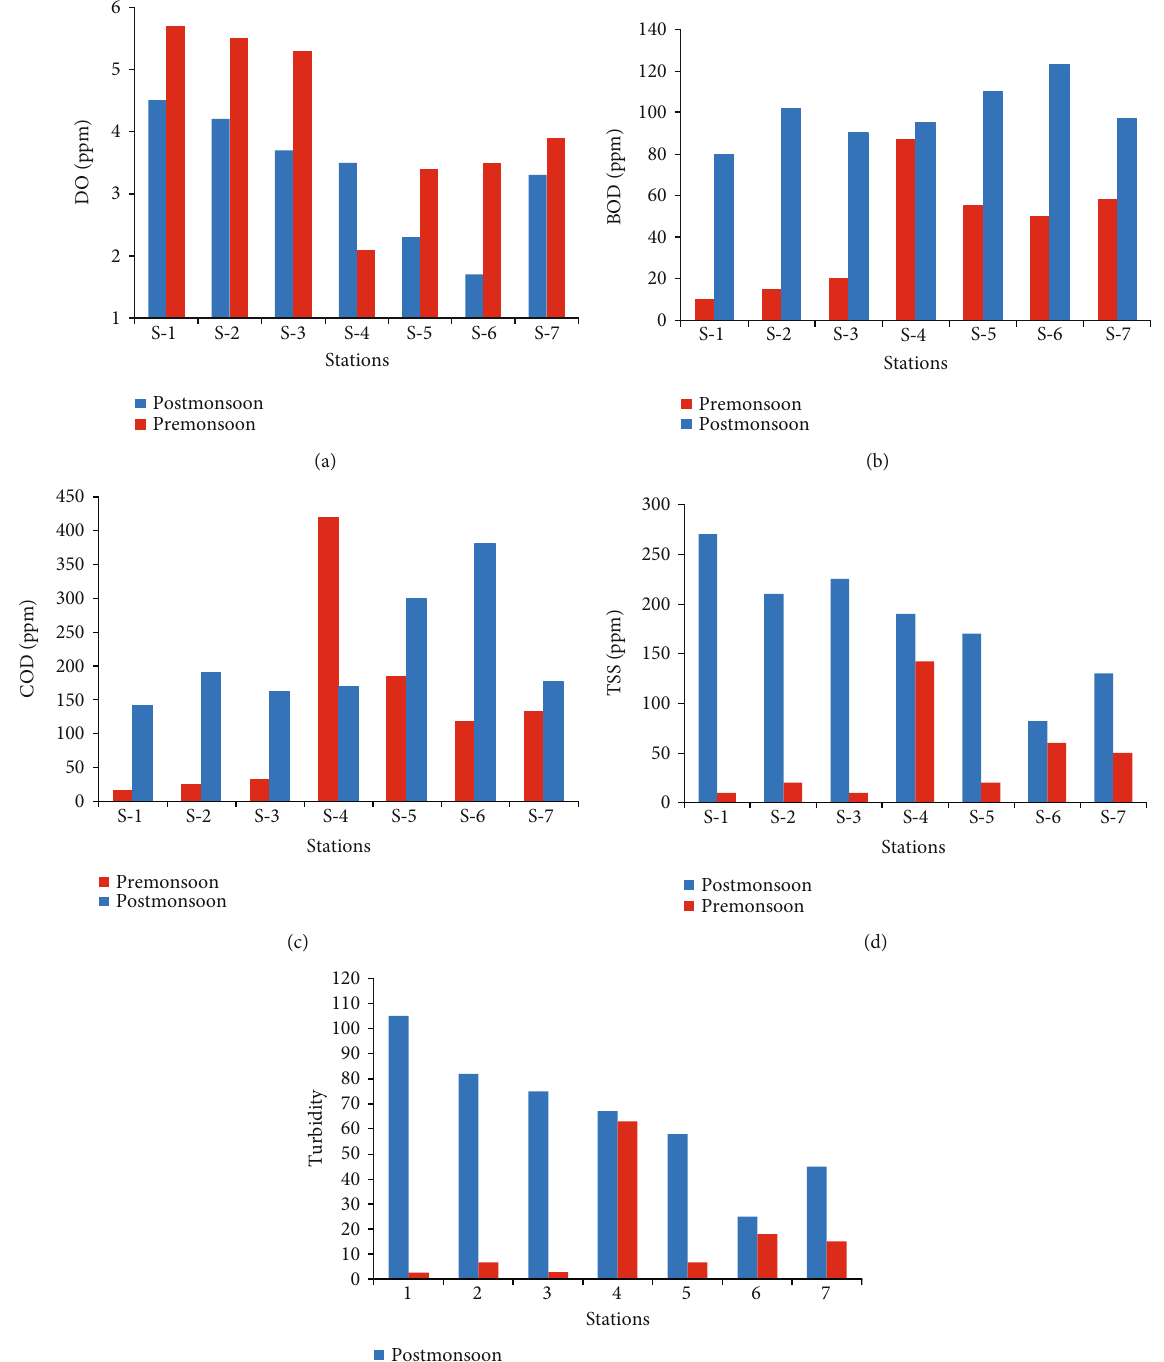
Figure 2: (a – e) Comparison between premonsoon and postmonsoon water quality variations in the Soan River: (a) dissolved oxygen (DO), (b) biochemical oxygen demand (BOD), (c) chemical oxygen demand (COD), (d) total suspended solids (TSS), and (e)